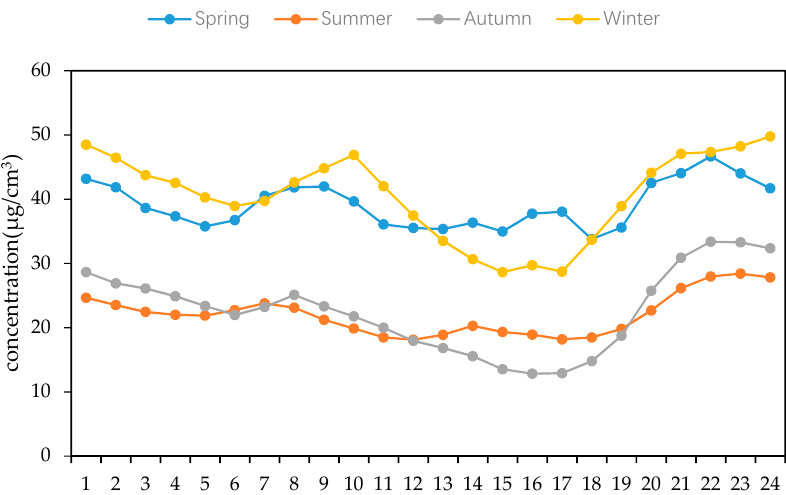
Figure 5. Variation in the hourly concentration of the PM 2.5 concentration in the four seasons of Changchun City in 2018.